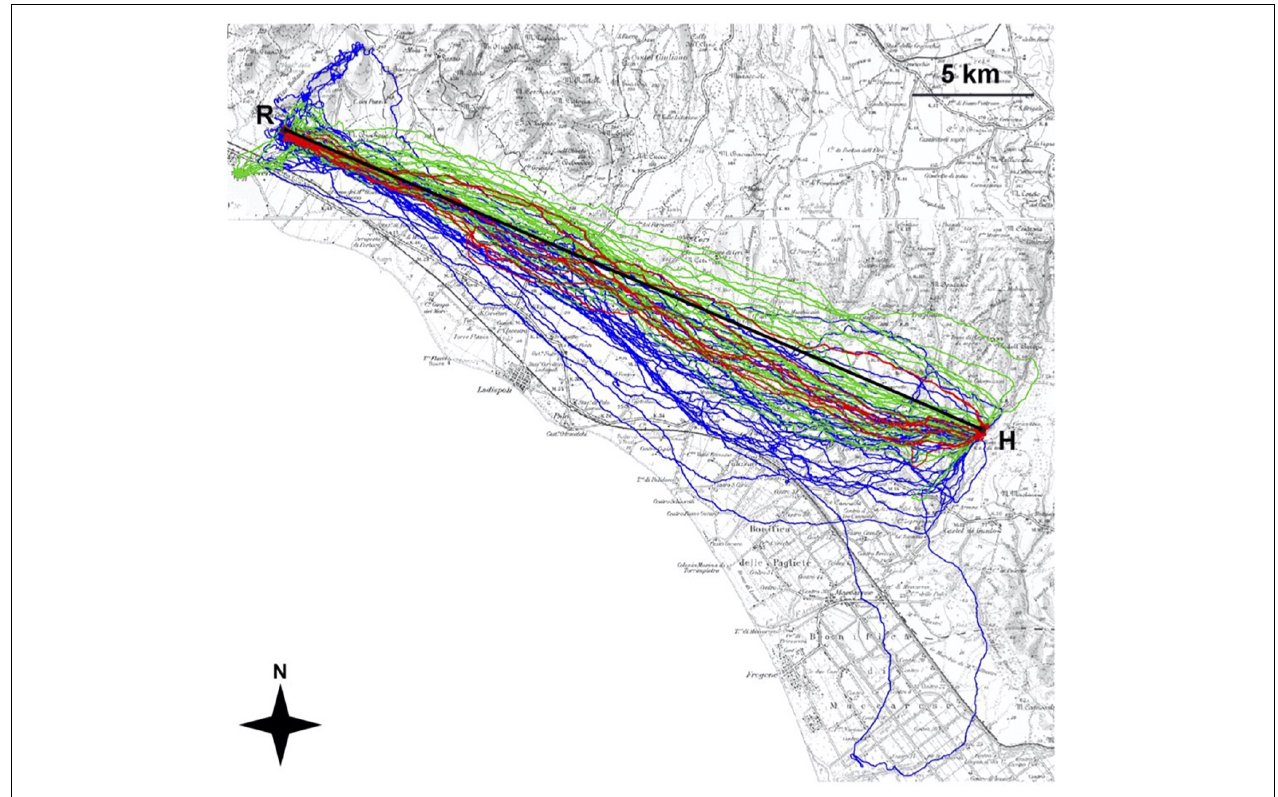
FIGURE 9 | GPS-tracked pigeon routes between a release location (R) and home loft (H). Six pigeons were released six times individually (blue), then six times as a flock (red; one track per flock release), then pigeons were released another six times individually (green). Pigeons released with a small flock flew faster and more direct routes compared to their routes when released alone. Figure from Dell’Ariccia et al. (2008) with